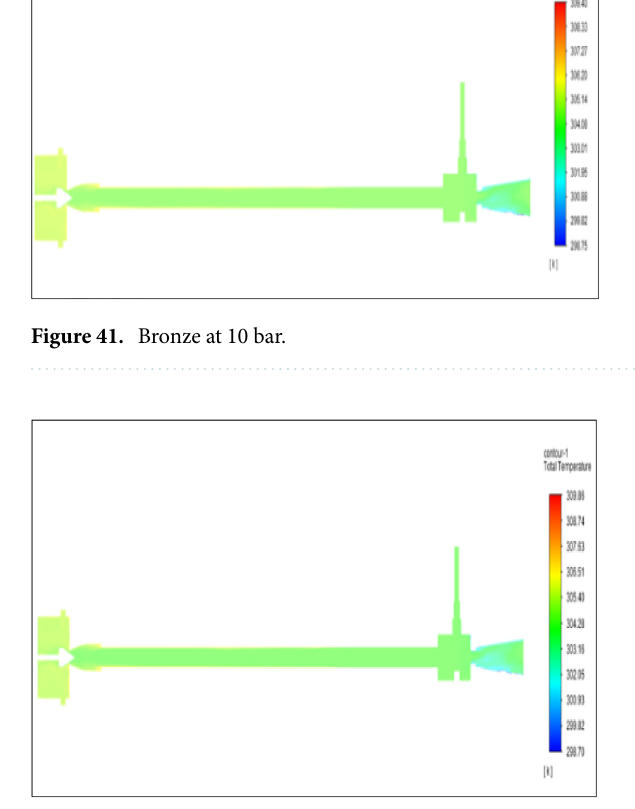
Figure 42. Copper at 10 bar.